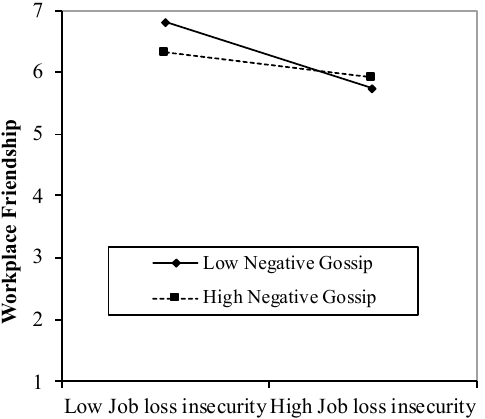
Figure 1. Buffering effect of the tendency to negative gossip on the negative relationship between job loss insecurity and workplace friendships.